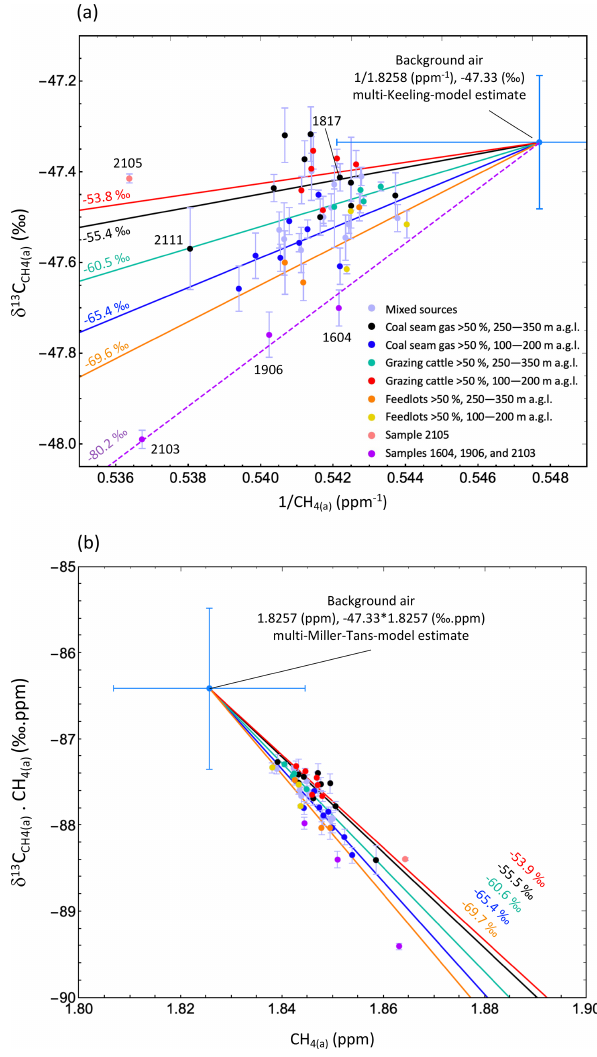
Figure 5. Multiple regression with shared CH 4(b) and δ 13 C CH 4(b) for the Keeling model ( a , solid lines, Eq. 1) and the Miller–Tans model ( b , solid lines, Eq. 3) for the category subsets listed in the colour key. Refer to Table A5 for all regression results and their er- ror statistics. The δ 13 C CH signature for each category is listed 4(s) near the lines of best fit for each category. The dashed purple line in (a) shows a Keeling model (Eq. 1) fitted to IFAA samples 1604, 1906, and 2103 (for this regression CH 4(b) and δ 13 C CH were 4(b) fixed to match the results of the multi-Keeling-model regression with shared CH 4(b) and δ 13 C CH ). To highlight the subtle dif- 4(b) ferences in the multiple regression best-fit parameters, the derived CH 4(b) and δ 13 C CH values are given to an extra significant fig- 4(b) ure in (a) and (b) compared to the measurement precision. All error bars are 1 standard